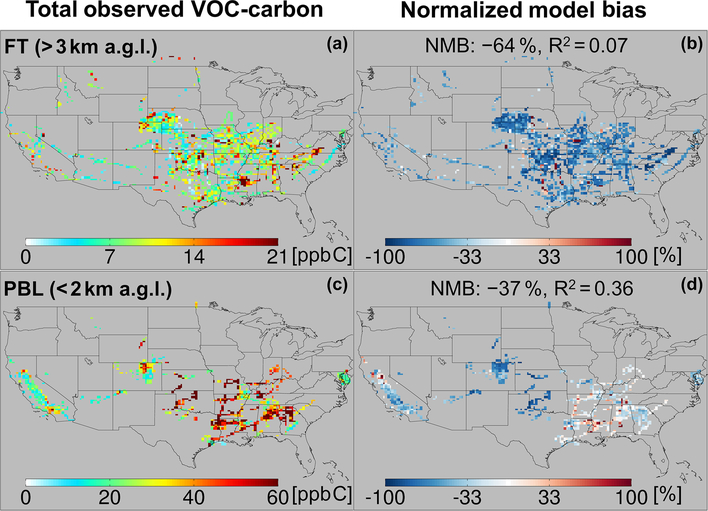
Total observed VOC reactivity (a, c) over North America in the free troposphere (> 3 km a.g.l.) and planetary boundary layer (< 2 km a.g.l.). In (b, d), the GEOS-Chem model simulation is compared to co-located aircraft observation with the normalized mean bias given inset. Note that the sampling season and instrument payload vary among campaigns.